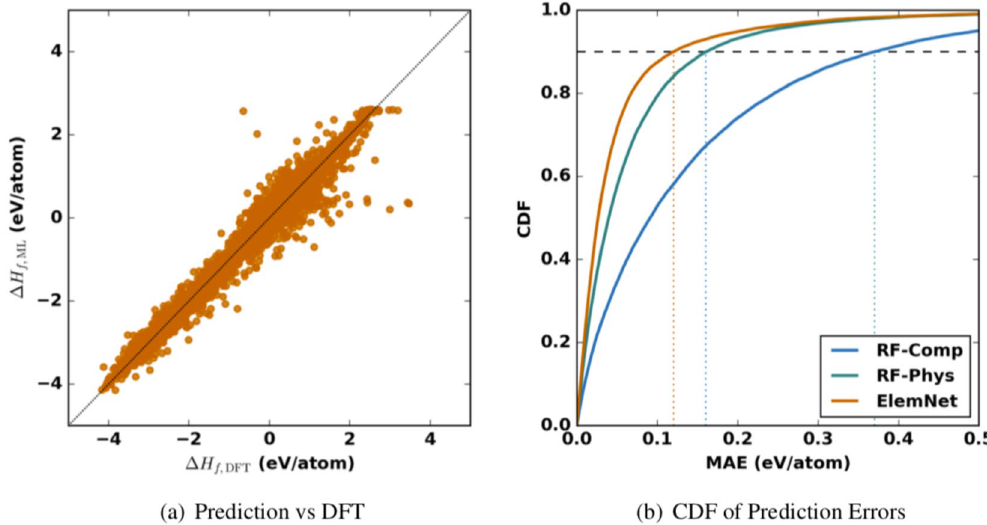
Figure 4. Error analysis of the predictions using ElemNet of a test set containing 25,662 compounds from our ten-fold cross validation. The left side shows that the predicted values are very close to the DFT-computed values. The right side illustrates the cumulative distribution function (CDF) of the prediction errors for ElemNet and Random Forest (the best performing conventional ML model) with elemental fractions (RF-Comp) and physical attributes (RF-Phys). Our error analysis demonstrates that the deep learning performs very well, achieving an MAE of 0.050 ± 0.000 eV/atom; predicting with an absolute error of less than 0.120 eV/atom for 90% of the compounds in our test set